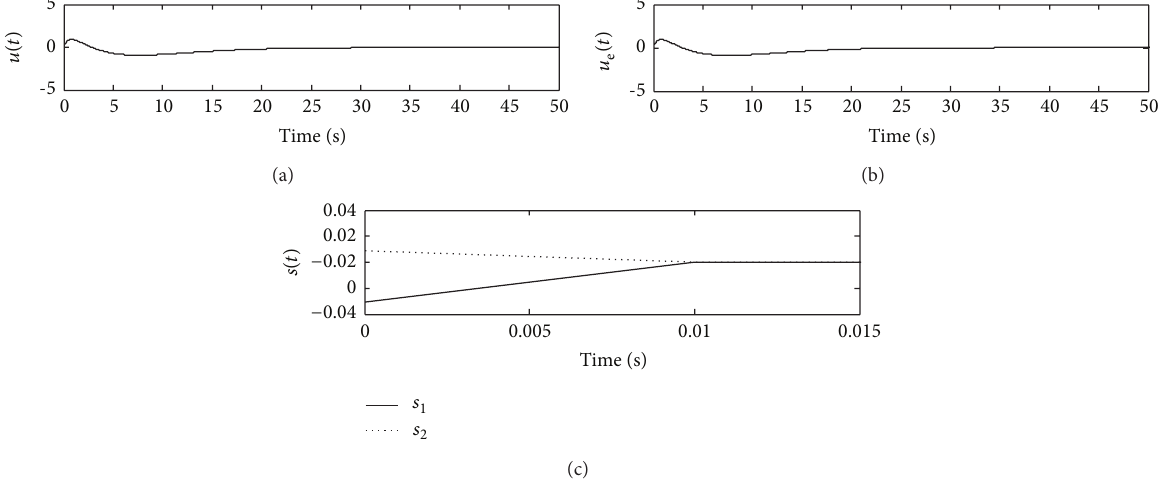
Figure 4: Control inputs and sliding mode surface under attenuated